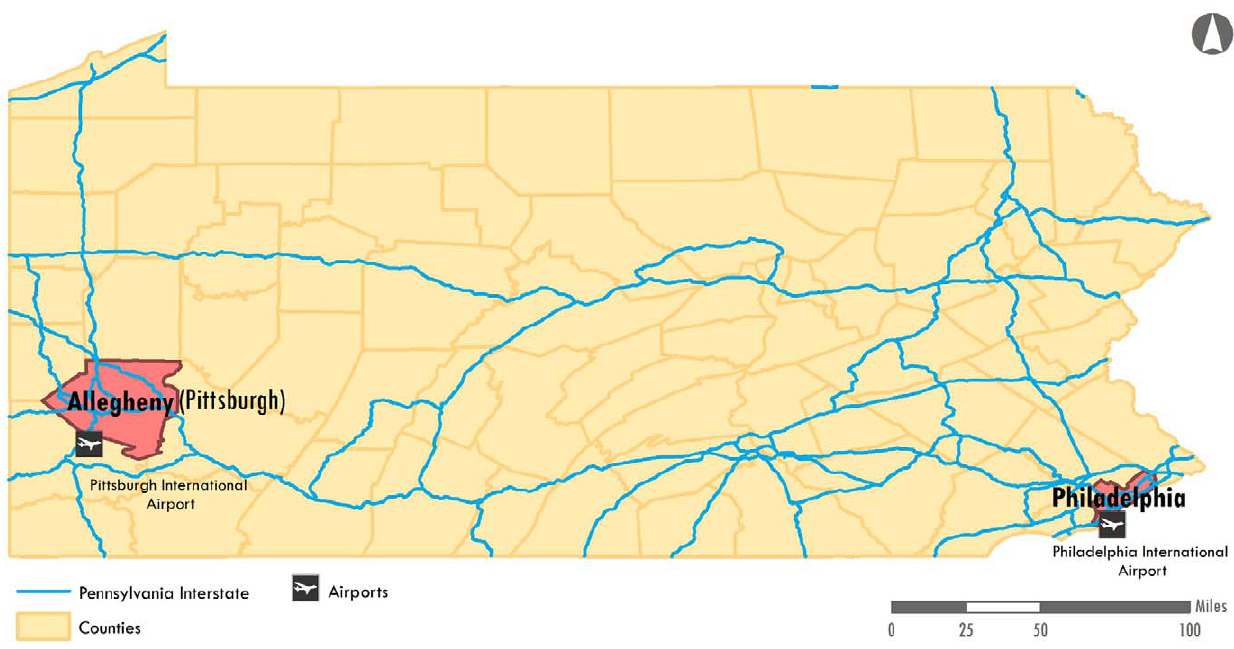
Figure 1. Map of Pennsylvania, US detailing the county boundaries, urban areas, and transportation networks. Pittsburgh in Allegheny County is highlighted in the West and Philadelphia is highlighted in the South East. Both urban areas have international airports and are connected by a major interstate highway.